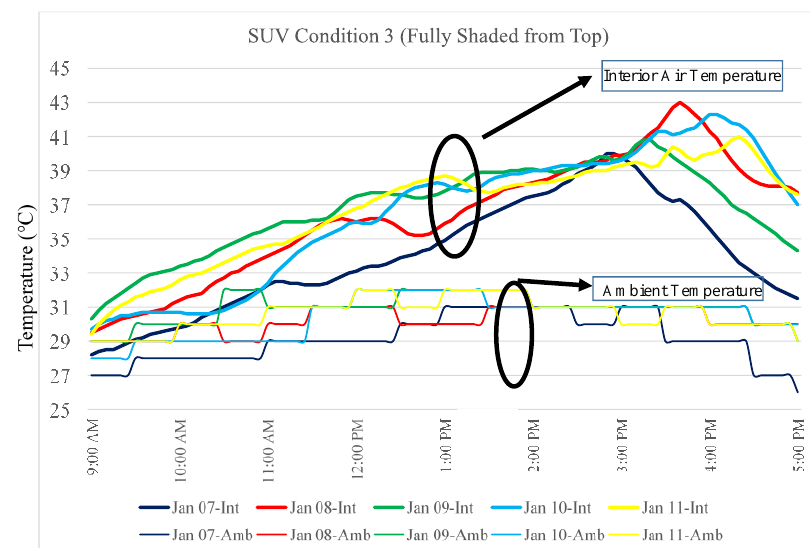
Figure15. Condition 3 for SUV